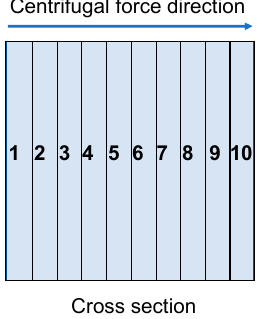
Figure 4. Spectrum for element analysis by EDX.